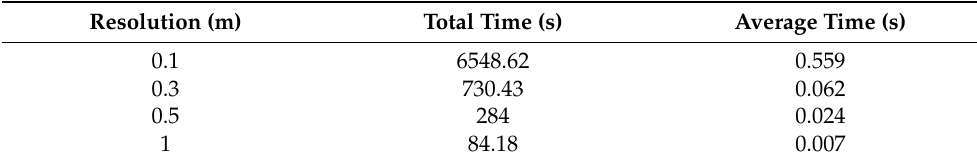
Table 6. The time consumption of the proposed method for dataset 2 under different map